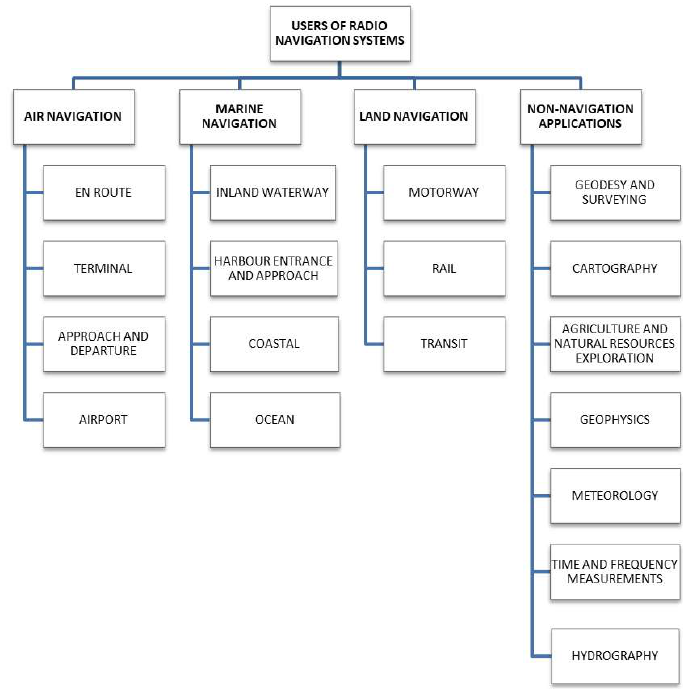
Figure 1. Users of radio navigation systems.